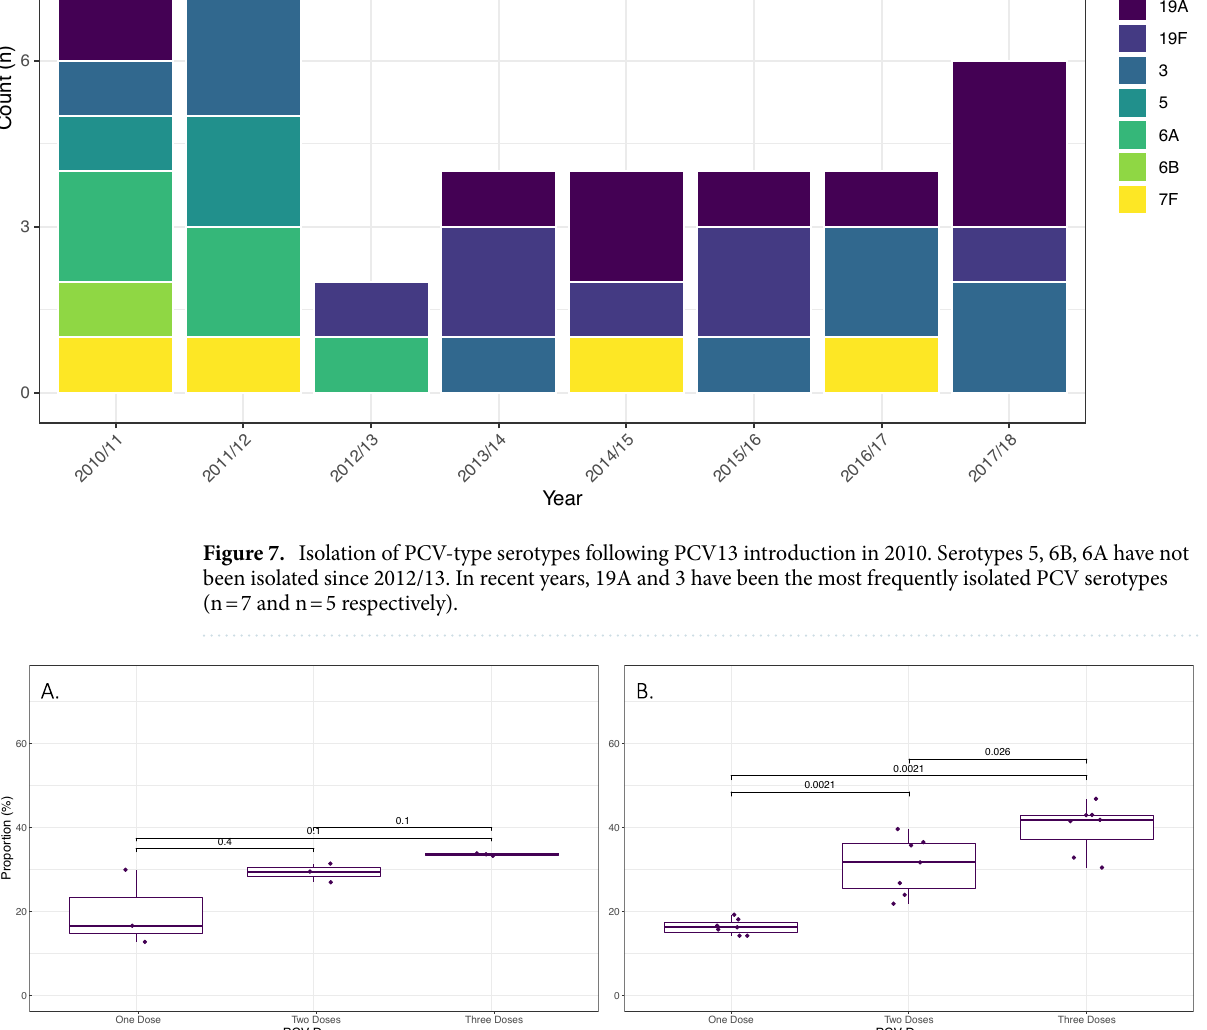
Figure 8. Impact of the estimated number of PCV doses on pneumococcal carriage for PCV7 ( A .) and PCV13 ( B .). Carriage as a proportion of number of children within each dose category was significantly higher as dose number increased for PCV13 but not PCV7. Error bars represent 95% CI. Significance values shown are from Kruskal–Wallis comparison of